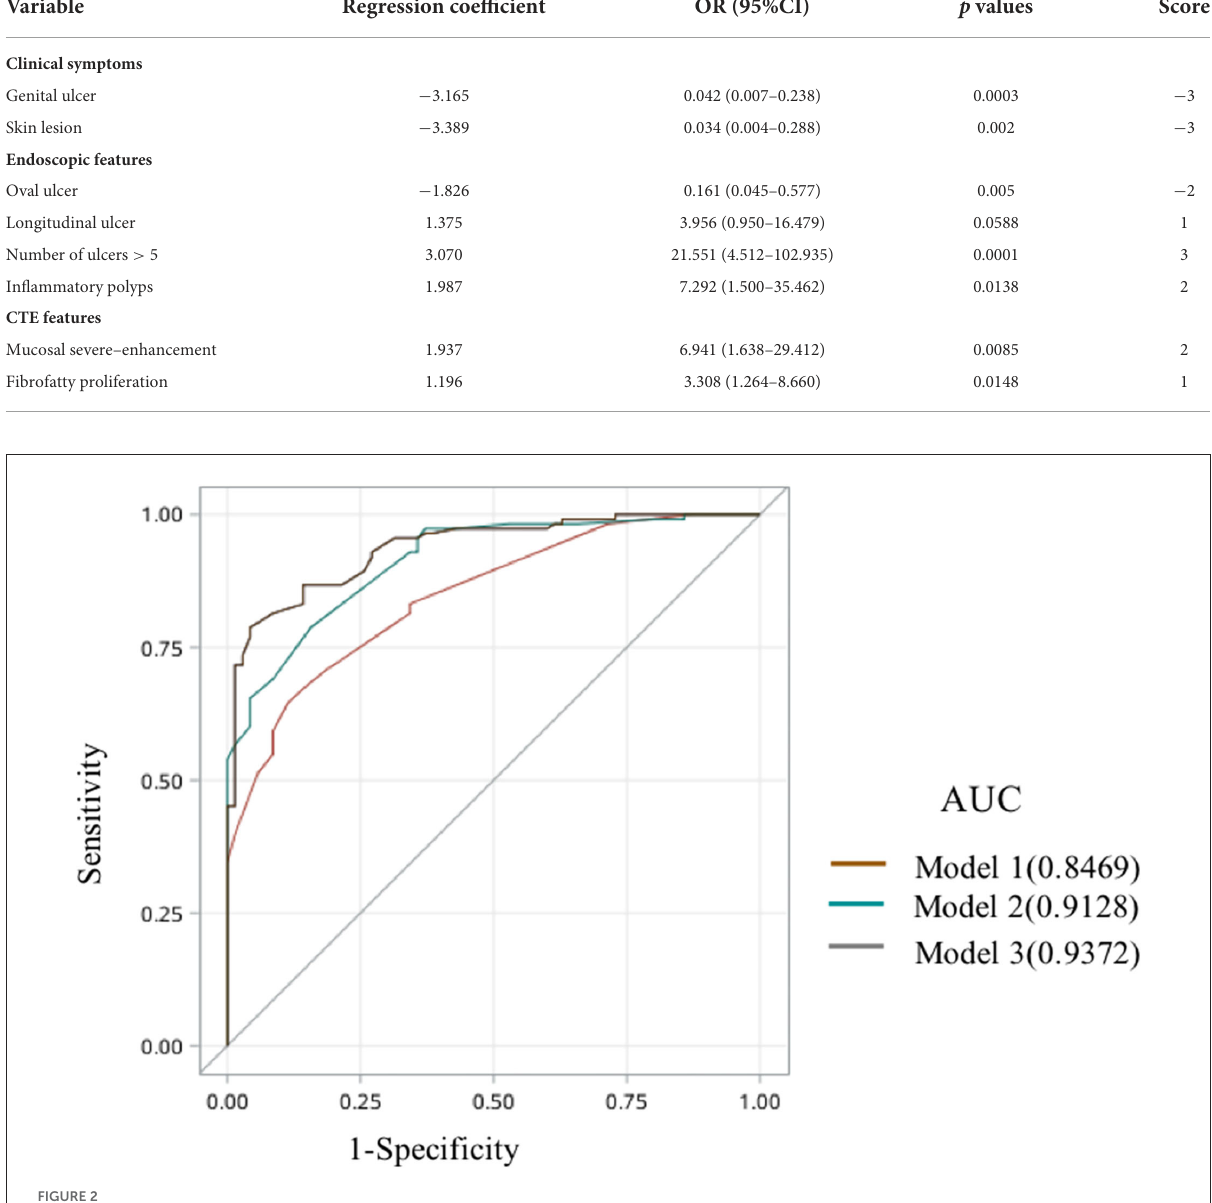
FIGURE2 The receiver operating characteristic curve of model 1, model 2, and model